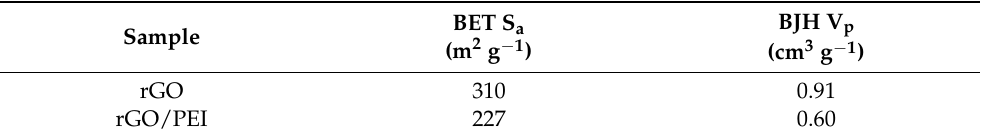
Table 1. The textural properties of the studied sorbents including the BET (Brunauer–Emmet–Teller) surface area (S a ) and the BJH (Barrett–Joyner–Halenda) pore volume (V p